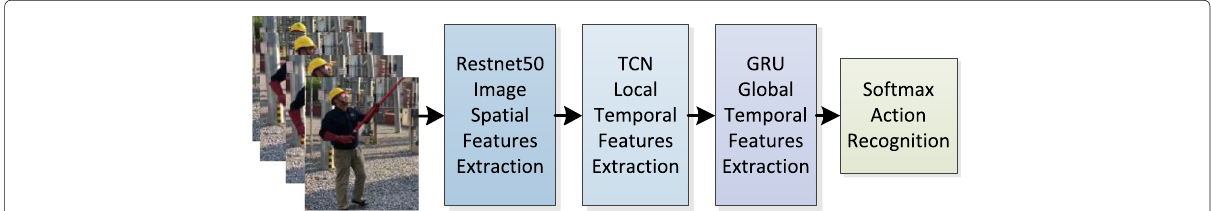
Local temporal feature extraction based on TCN TCN is a one-dimensional convolution in the time dimen- sion. The characteristics of its convolution calculation determine that TCN has a very good local feature extrac- tion ability. At the same time, because the discrimi- nation of unsafe actions is mainly for the purpose of action prediction, only the frame information in front of the moment is used, and the information